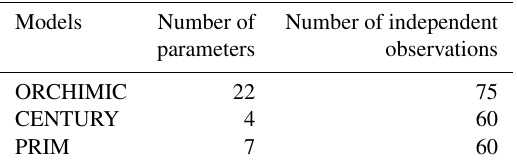
Table 5. Number of parameters and observations used in the opti- mization for each